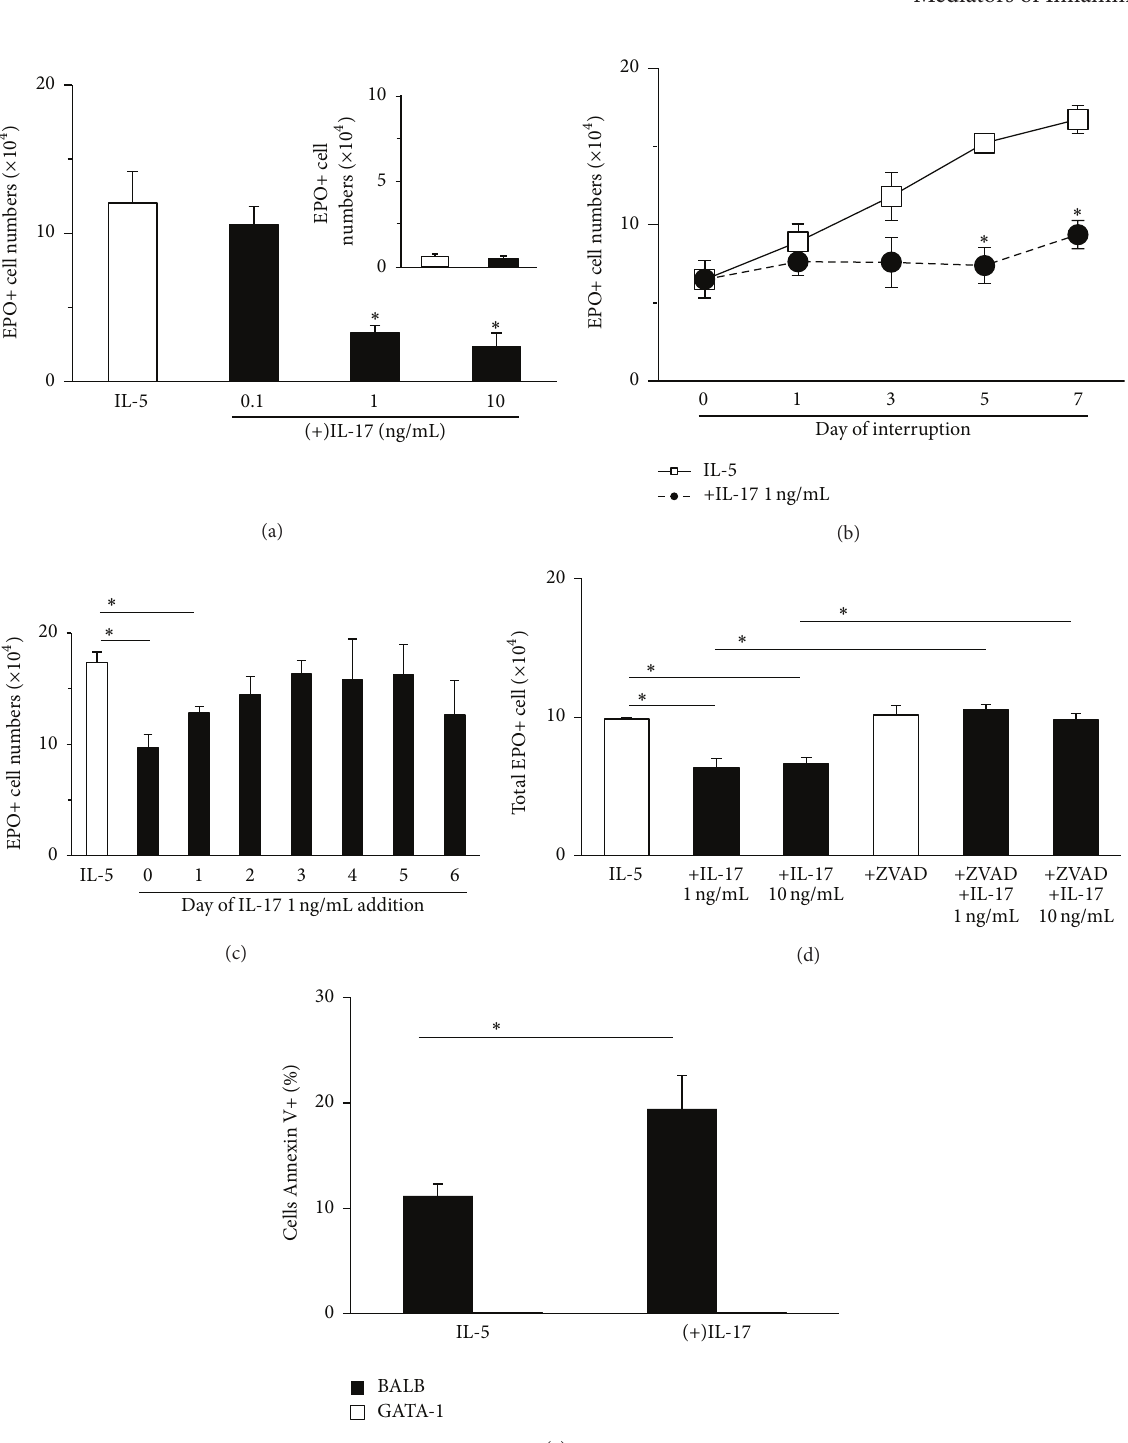
Figure 1: Effect of IL-17A on eosinophil production from murine bone-marrow. Bone-marrow cultures were established from BALB/c mice in the presence of IL-5 (1ng/mL), alone or in association with the indicated concentrations of IL-17A. After the indicated periods, cells were collected, counted, and stained for eosinophil peroxidase (EPO). Total and EPO+ cell counts were performed, and data (mean ± SEM, 𝑛 = 4 ) are the numbers of EPO+ cells present at the end of the culture. (a) Effect of varying IL-17A concentration on EPO+ cell numbers at day 7. Insert : effect of culture in the absence of IL-5; open and closed bars: cultures established, respectively, with and without IL-17A. (b) Effect of increasing duration of culture. (c) Effect of variable timing of IL-17A addition relative to the initiation of the culture. (d) Effect of blocking terminal caspases with zVAD-fmk (z-VAD) (20 𝜇 M). (e) Annexin V-FITC staining of cells in the granulocyte gate recovered from BALB/c and GATA-1 day 5 bone-marrow cultures. Data are mean ± SEM ( 𝑛 = 3 ) of the % granulocytes in the gated region (FL-1 positive, FL-2 negative). At day 2, there was no significant difference between IL-17A-exposed and control cultures from BALB/c mice (not shown). ∗ 𝑃 < 0.05 for the differences between the indicated points and the respective IL-5 (negative)